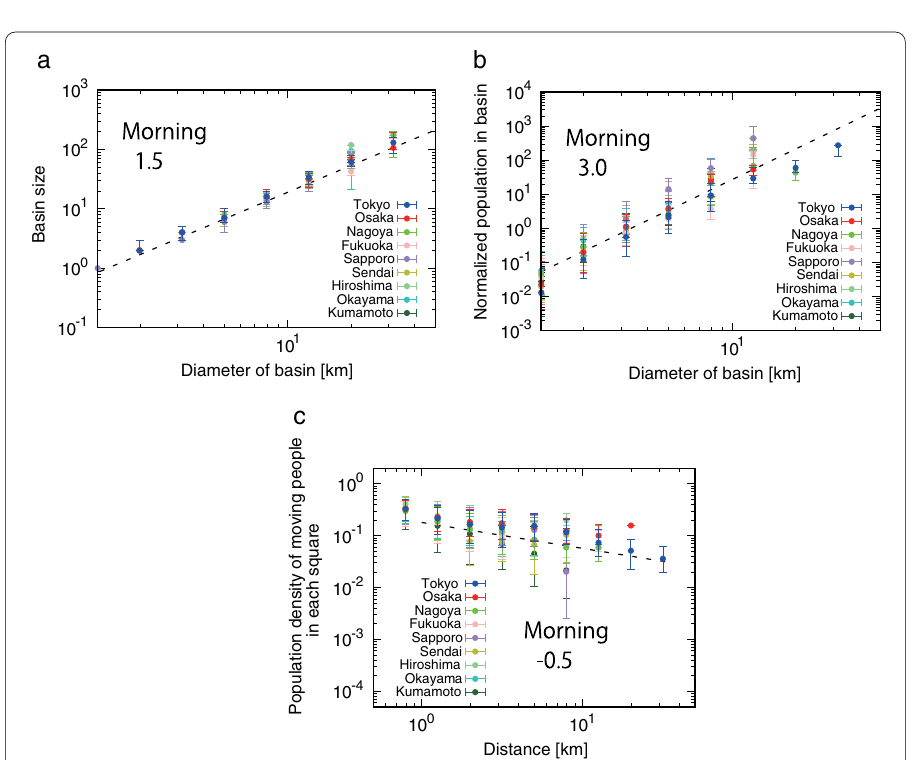
Fig. 5 The structure of basins during COVID-19 pandemic. a , The size of the basin increases is proportional to the diameter to the 1.5th power. The definition of diameter is the maximum distance between two points in the basin, see reference (Shida et al. 2020). b , The number of moving people in the basin is proportional to the cube of the diameter. c , Based on the square with the highest density of moving people in the basin, the number of moving people decreases with distance to the power of −